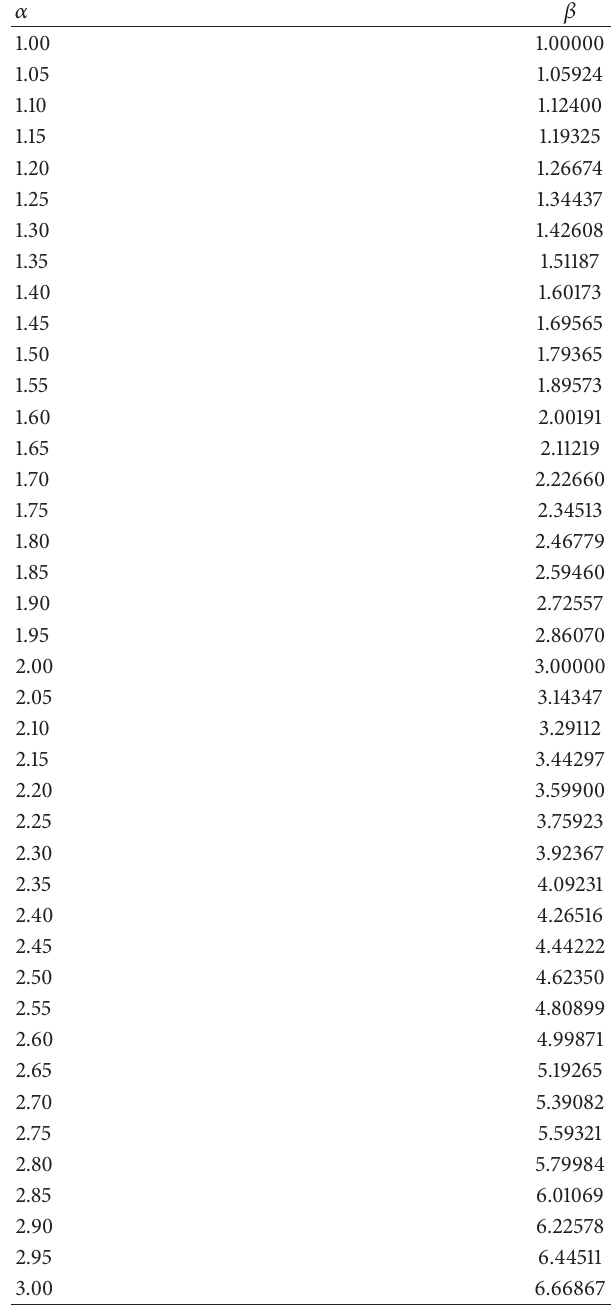
Table 1: Boundary line data